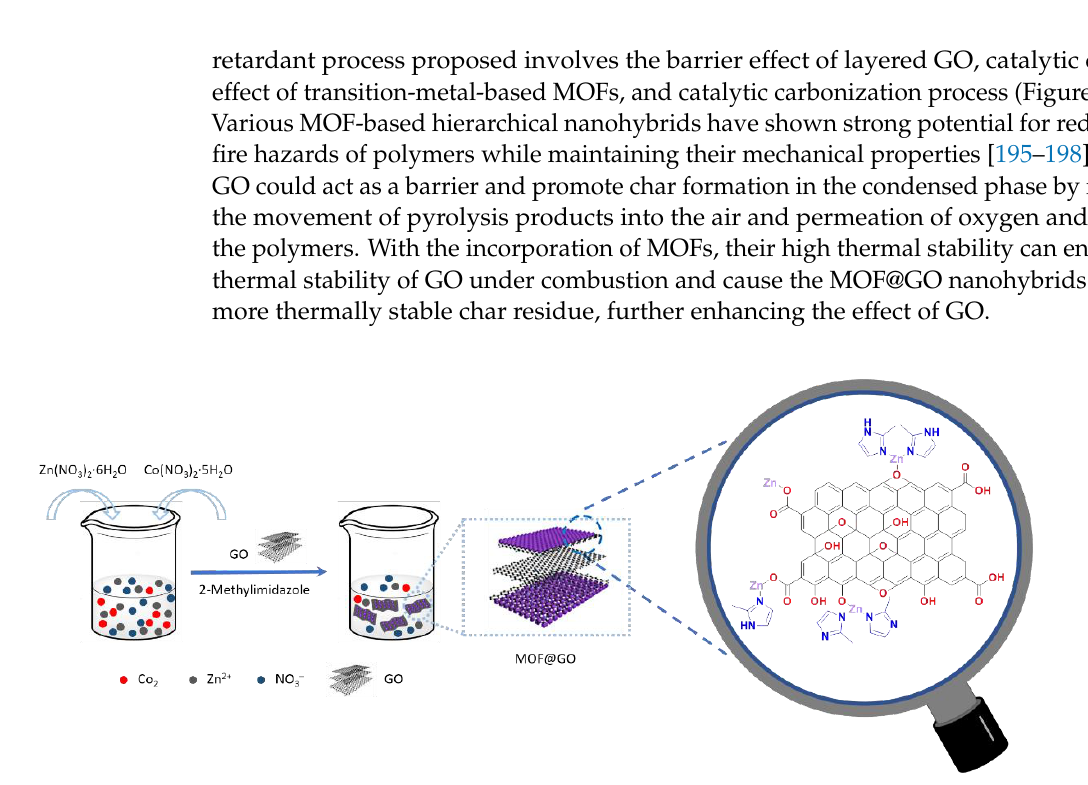
Figure 27. Schematic of the preparation of Zn/Co MOF@GO nanohybrids. Reprinted with permission from Ref. [195].